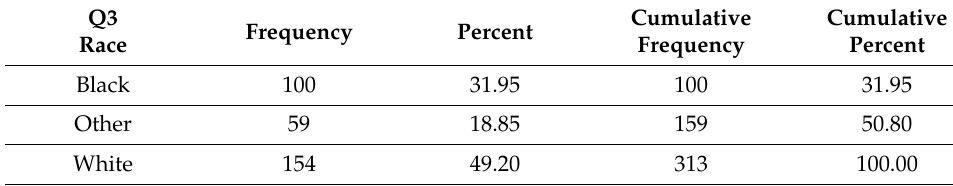
Table 3. Frequency for combined race.